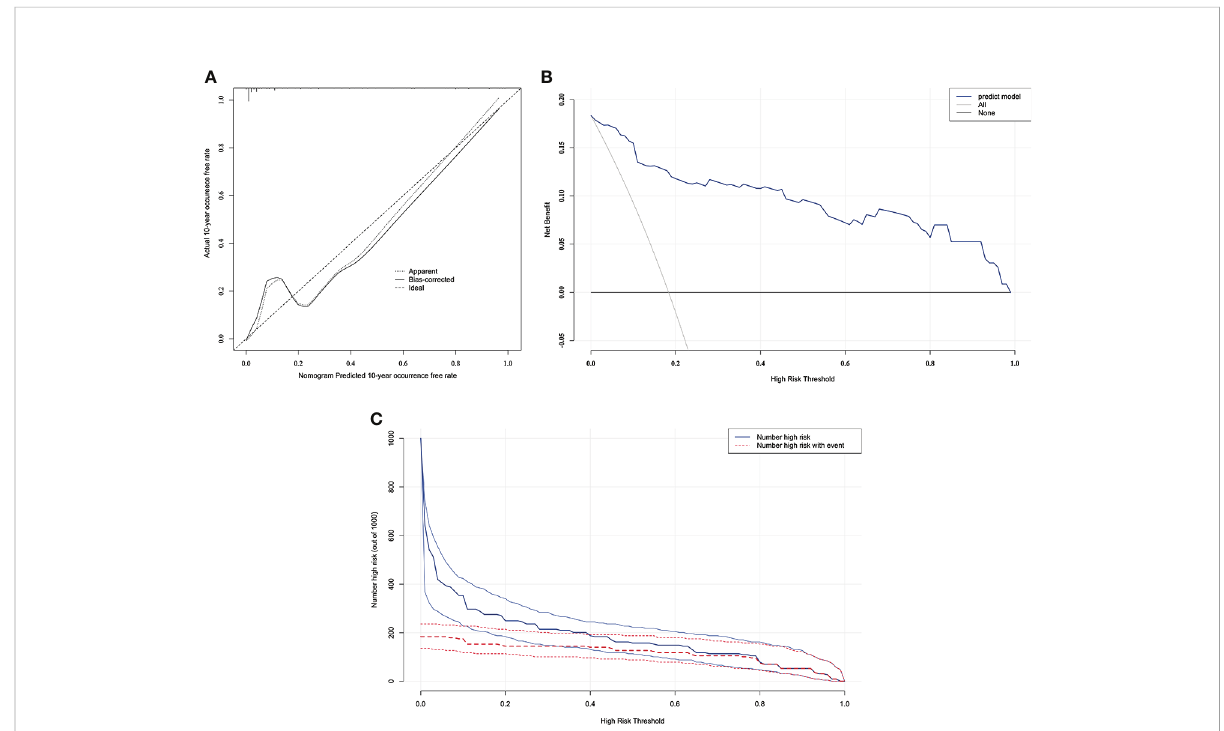
FIGURE 6 The calibration curve and results of the DCA and the CIC analysis of the nomogram in the validation cohort. (A) Calibration curves represent the difference between the actual prediction and the ideal perfect prediction (45 ◦ line). (B) The DCA curve of the nomogram for predicting ABP. It revealed that the nomogram could obtain a greater net bene fi t than either the “ treat all ” or the “ treat none ” strategy. (C) The CIC curve of the nomogram for predicting ABP. The solid blue line (Number high risk) represents the number of ABP patients predicted using the nomogram at each threshold probability; the dotted red line (number high risk with event) represents the number of true-positive ABP patients at each threshold